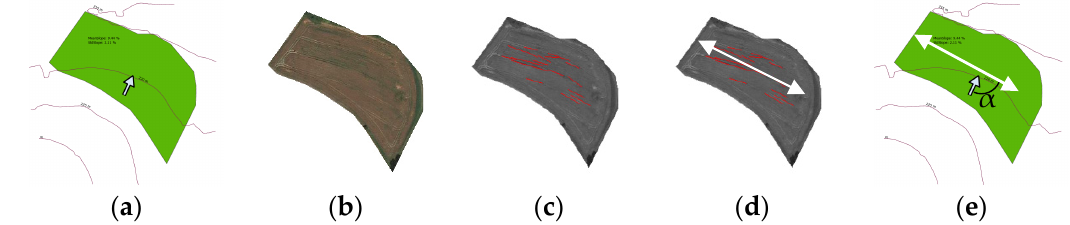
Figure 2. Workflow of land-parcel-based application of Fast Line Detector to high-resolution remote sensing data for automated derivation of main cultivation direction and verification of support practice measure contouring: ( a ) DEM analysis; ( b ) preparing remote sensing data; ( c ) applying FLD; ( d ) deriving main cultivation direction; ( e ) comparing of directions; data source: [30,40,41].